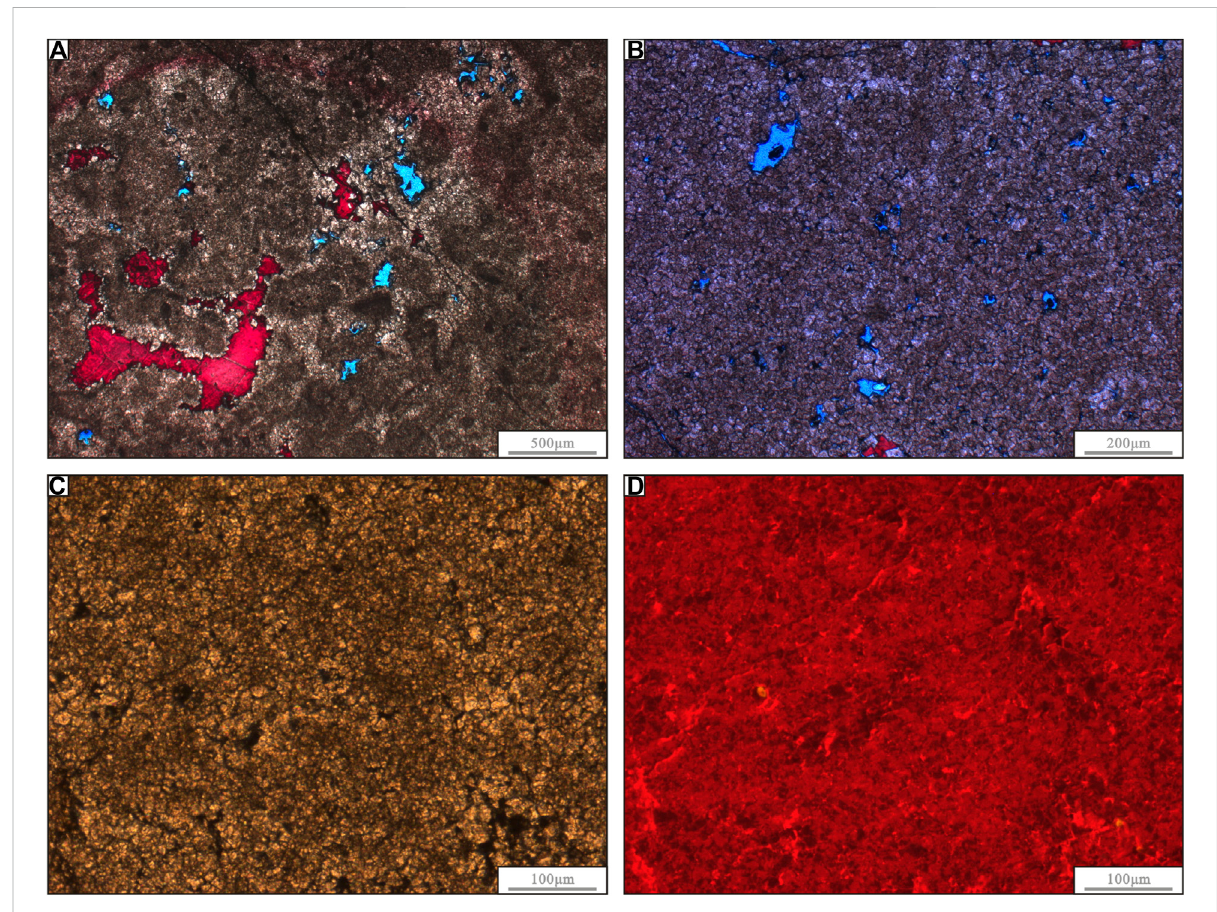
FIGURE 2 Petrological characteristics of Rd1. (A) . Plane-polarized-light image of an Rd1 sample showing nonplanar-a textures in small areas, with some calcite- fi lled pores. The sample was obtained from well QZ12 in the Buqu Formation at a depth of 140.86 m. (B) . Plane-polarized-light image of an Rd1 sample showing nonplanar-a textures in most areas and an algal stromatolitic texture in some areas, with a few calcite- fi lled pores. The sample was obtained from well QZ12 in the Buqu Formation at a depth of 65.00 m. (C) . Plane-polarized-light image of an Rd1 sample containing relatively dense peloids replaced by nonplanar-a dolomite to varying degrees, as well as scattered asphaltenes. The sample was obtained from well QZ12intheBuquFormationatadepthof134.58 m (D) .CathodoluminescenceimageoftheRd1samplein (C) .Thesecrystalsshowadull-dullorange light, which is brighter along the grain edge. In contrast, the asphaltene shows no